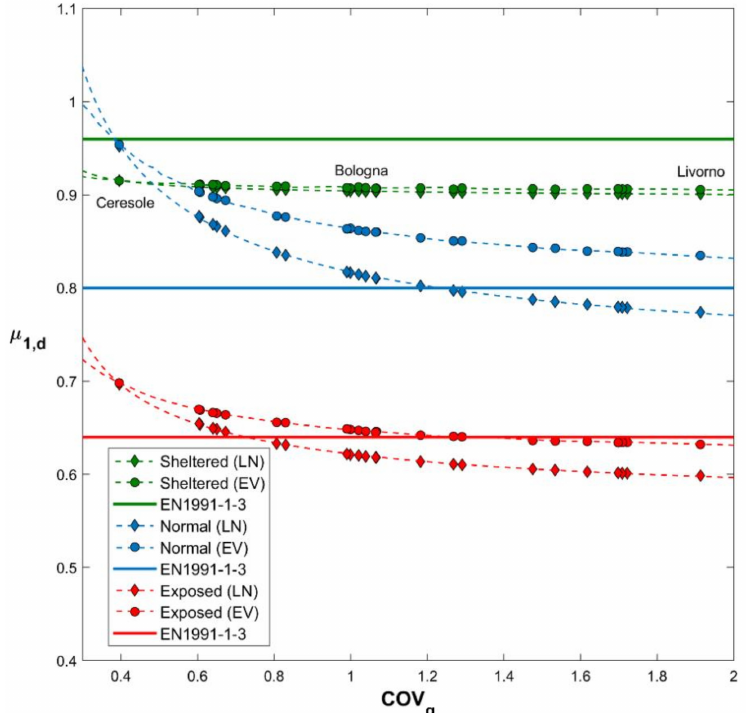
Figure 6. Design shape coefficient for flat roofs ( µ 1, d ) as a function of the coefficient of variation ( COV g ) of ground snow load, parameterized in terms of exposure conditions (sheltered: green lines, normal: blue lines, exposed: red lines) and distribution of the snow load on ground (log-normal: circular markers, Gumbel: lozenge markers) for 25 Italian weather